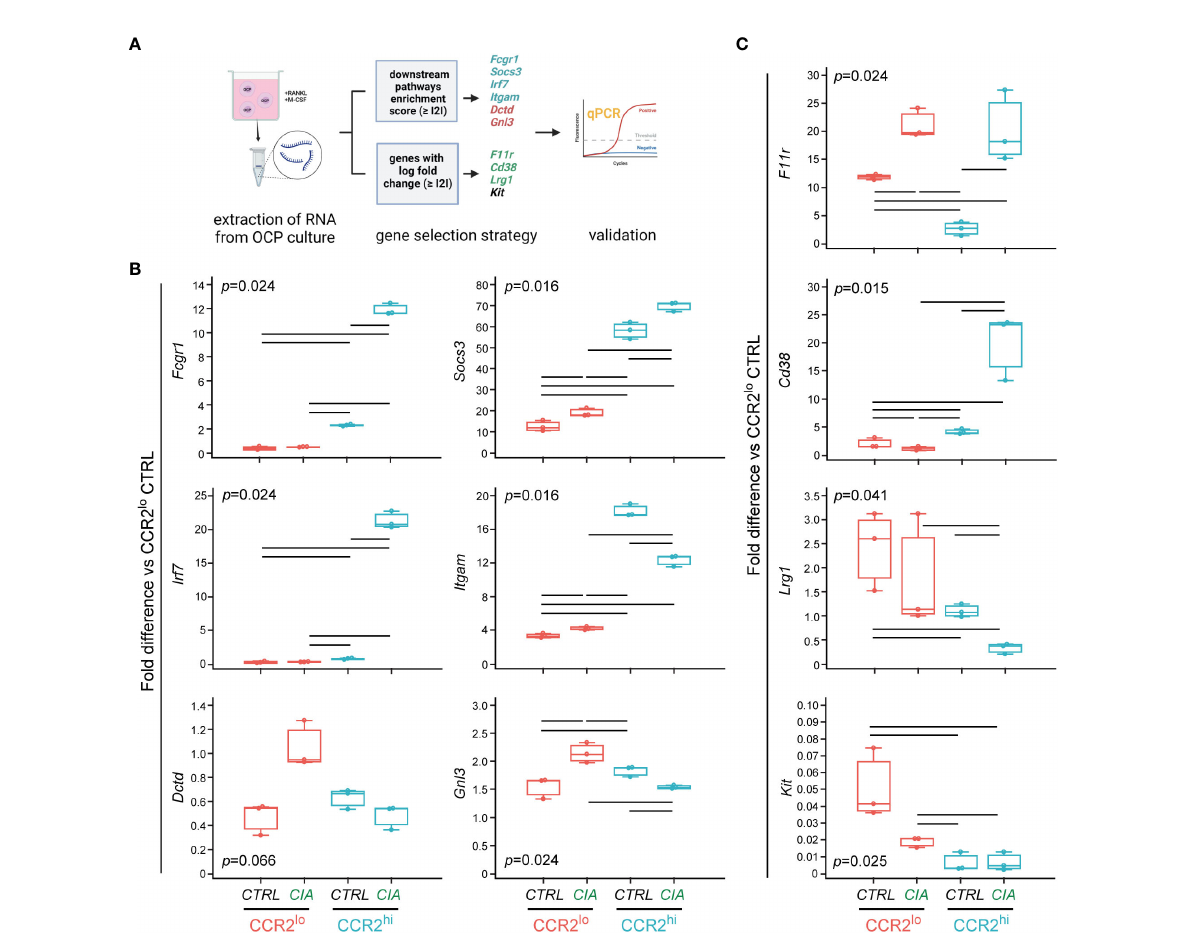
FIGURE 7 Evaluation of differentially expressed genes in committed preosteoclasts by qPCR. (A) Experimental design for qPCR analysis of gene expression in cultured OCPs. Sorted CCR2 lo and CCR2 hi OCP subsets from control (CTRL) mice and mice with collagen-induced arthritis (CIA) were cultured for two days with RANKL and M-CSF to induce osteoclast differentiation. RNA was extracted from cultured preosteoclasts and reversely transcribed to cDNA. Genes were selected based on the enrichment score and based on the log fold change, and analyzed in CIA and CTRL groups (pooled cells from n=3-5 mice, RNA extracted from n=6-8 wells, data presented as technical replicates n=3). Created with BioRender.com (B) qPCR analysis of genes within biological pathways signi fi cantly different between OCP subsets (CCR2 lo and CCR2 hi ), characterized as subset markers. (C) qPCR analysis of genes that have the most signi fi cant differential expression by intervention (CTRL or CIA), characterized as disease markers. (B, C) Gene expression was normalized to the Hmbs housekeeping gene and presented as fold difference relative to the calibrator sample (cDNA from CCR2 lo subset of CTRL, day 0). Individual values are presented; colored horizontal lines represent the median, boxes represent the interquartile range (IQR), and whiskers represent 1.5 times the IQR. Statistically signi fi cant difference (represented by black horizontal lines) was determined at p<0.05, Kruskal – Wallis test followed by Conover test for group-to- group